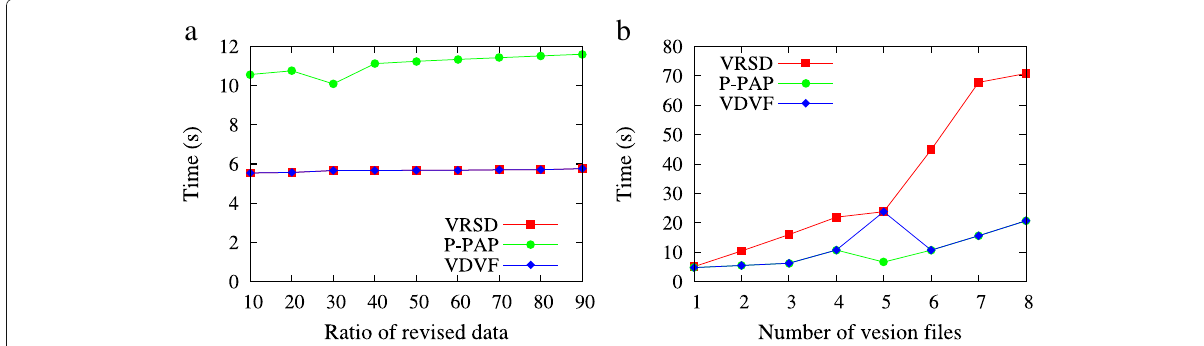
Fig. 9 Verification execution time. a different modification ratio. b different version